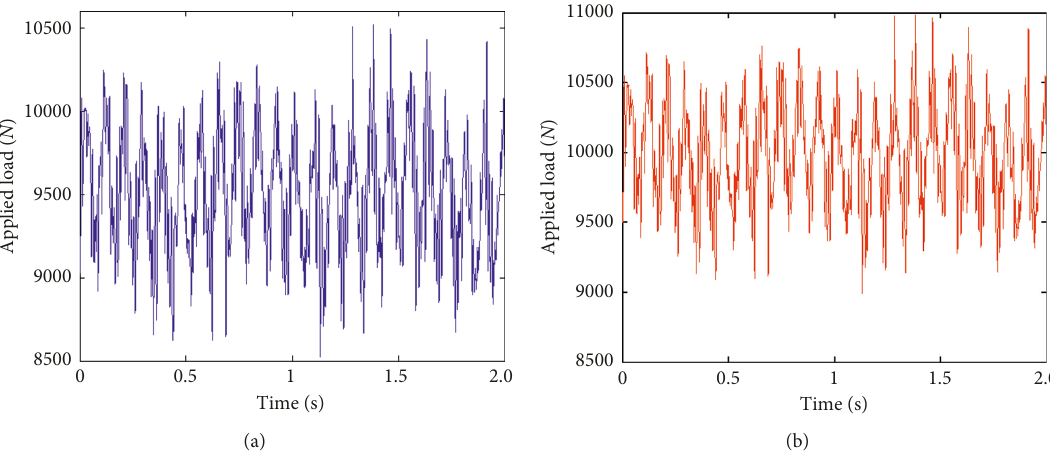
Figure 9: Loading-time course of the maximum load roller: (a) left- and (b) right-hand axle box